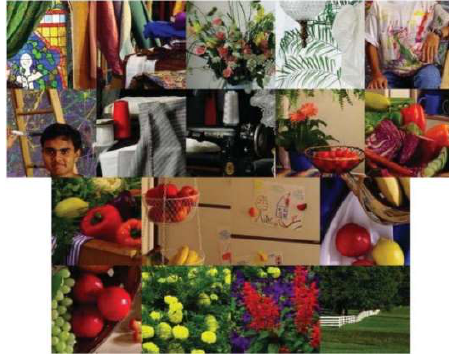
Figure 8. IMAX dataset (18 images).